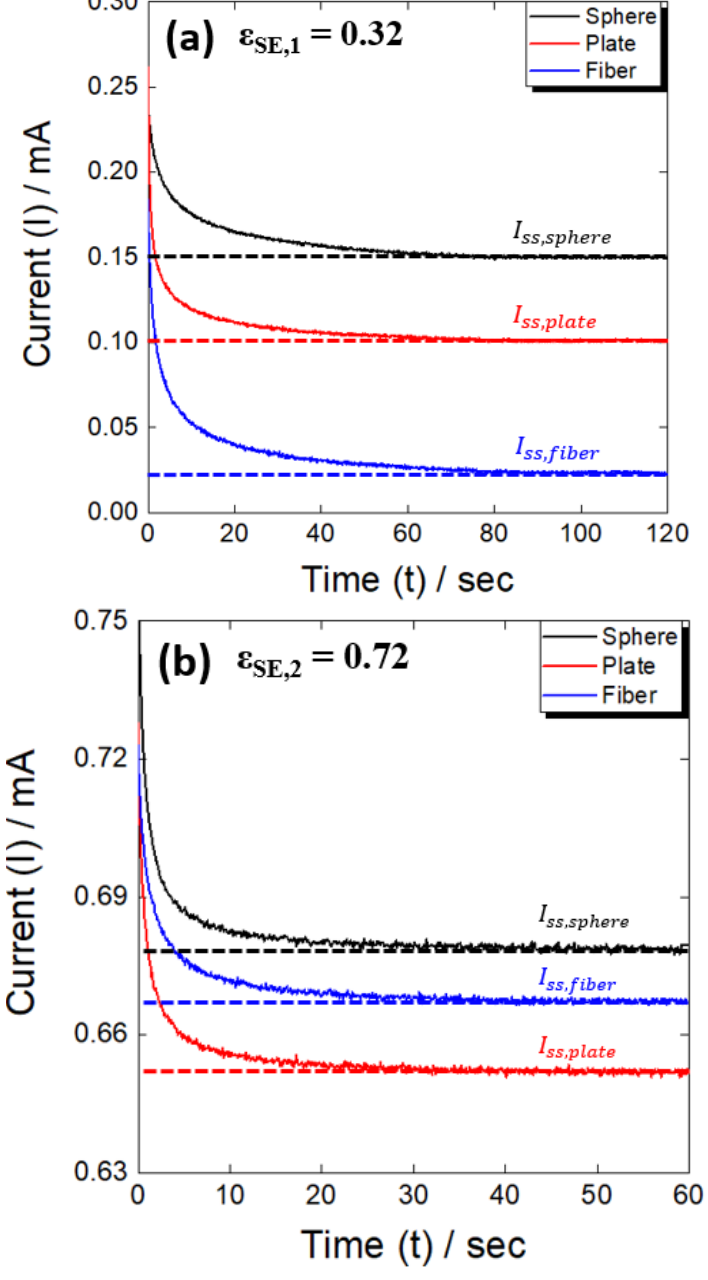
Figure 3. Chronoamperometric curves at ( a ) low ( ε SE,1 = 0.32) and ( b ) high (ε SE,2 = 0.72) volume fractions of solid electrolyte.